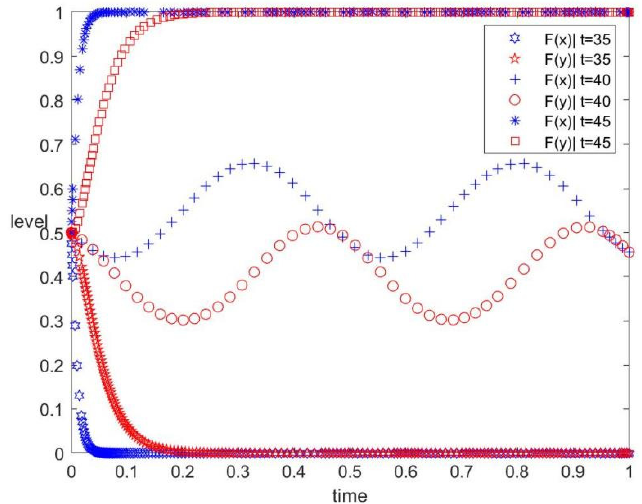
Figure 4. Evolution track under different tax intensities.